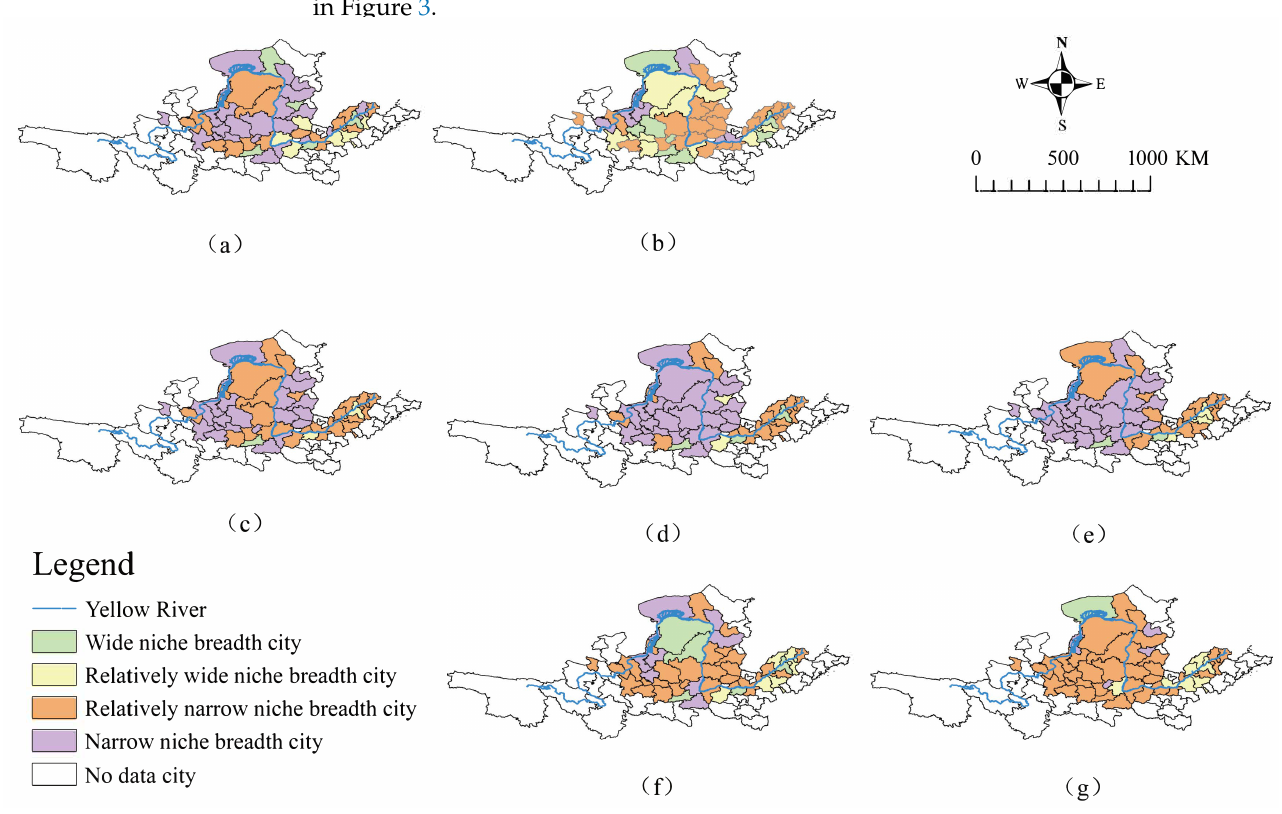
Figure 3. Spatial distribution of the niche breadth in the YRB cities for the period 2011 to 2020: ( a ) Spatial distribution of the niche breadth of infrastructure resources. ( b ) Spatial distribution of the niche breadth of service industry resources. ( c ) Spatial distribution of the niche breadth of openness resources. ( d ) Spatial distribution of the niche breadth of innovative resources. ( e ) Spatial distribution of the niche breadth of industrial resources. ( f ) Spatial distribution of the niche breadth of agricultural resources. ( g ) Spatial distribution of the niche breadth of ecological environment